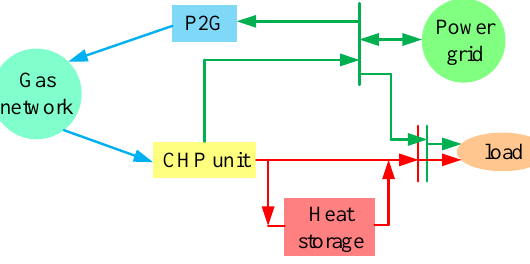
Figure 3. Principle of decoupling the mode of FTL.